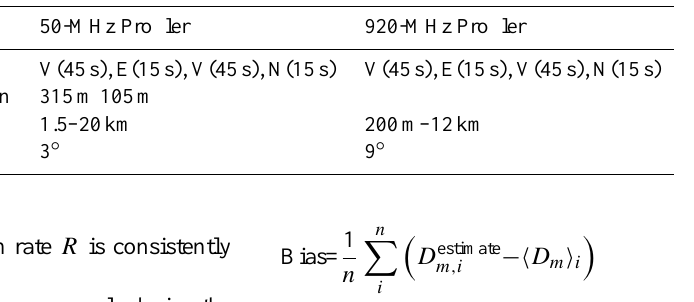
Fig. 6. Panel (a) shows the histogram of h D m i occurrence for all 26725 ensembles as a function of retrieved h D m i (solid line) and the percent accumulation from 0 to 100% (dashed line). Panel (b) shows the histogram of σ { D m } for the small range of 1 . 45 < h D m i < 1 . 55mm. Panel (b) also shows the percent accumulation from 0 to 100% of these 2474 ensembles in this sub-set. The values of the 10th, 50th, and 90th percentiles are indicated in the two panels. Table 1. Operating parameters of the Darwin 50- and 920-MHz profilers (V is vertical, E is east, and N is